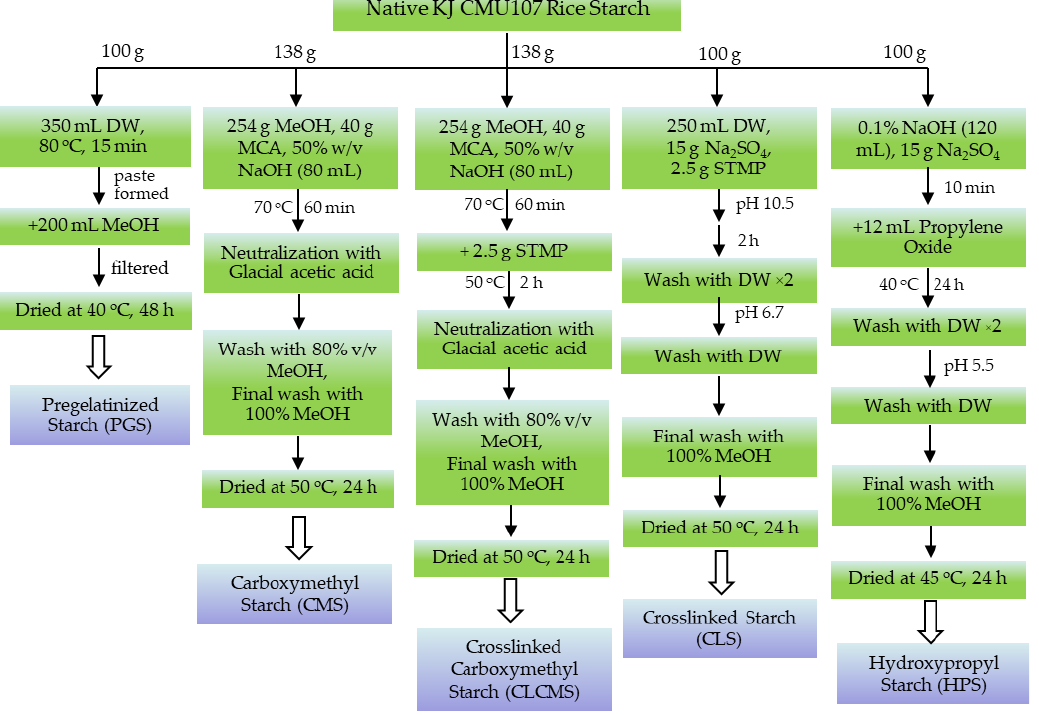
Figure 1. Synthesis Schemes for the Preparation of Modified Starches.